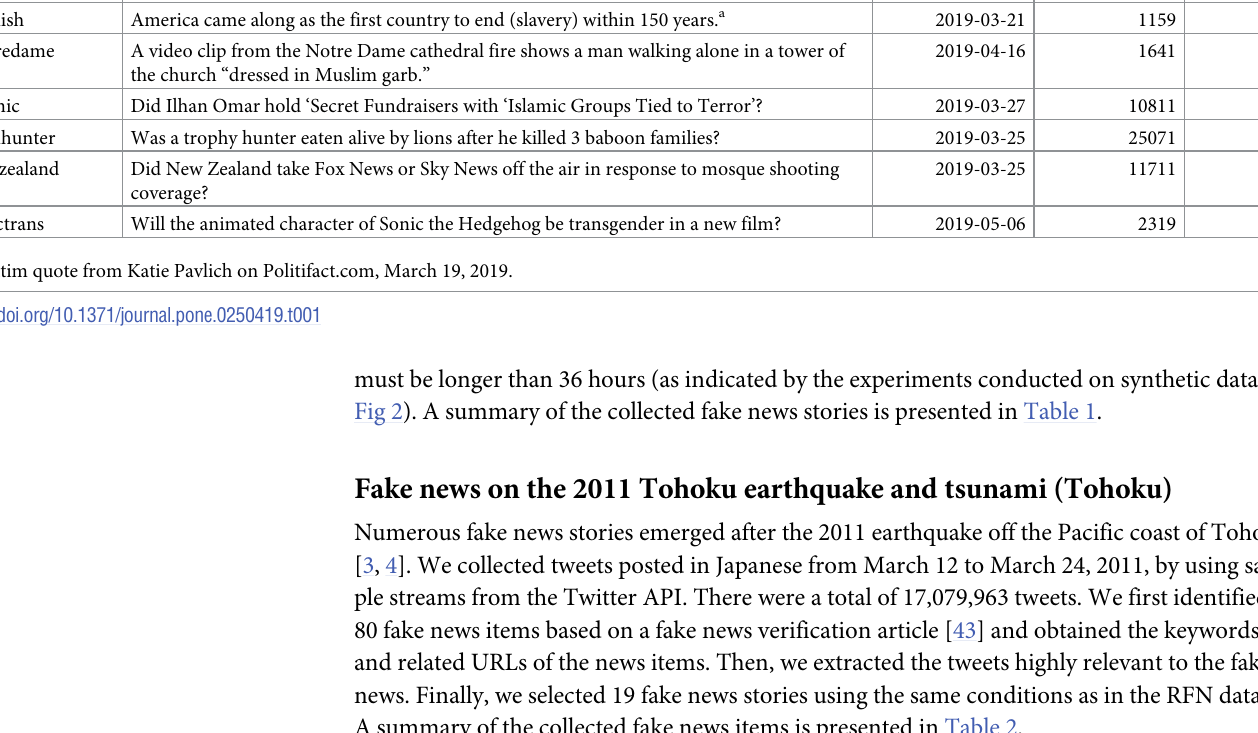
Table 1. Recent Fake News (RFN): Details of 6 U.S. fake news items. News No.